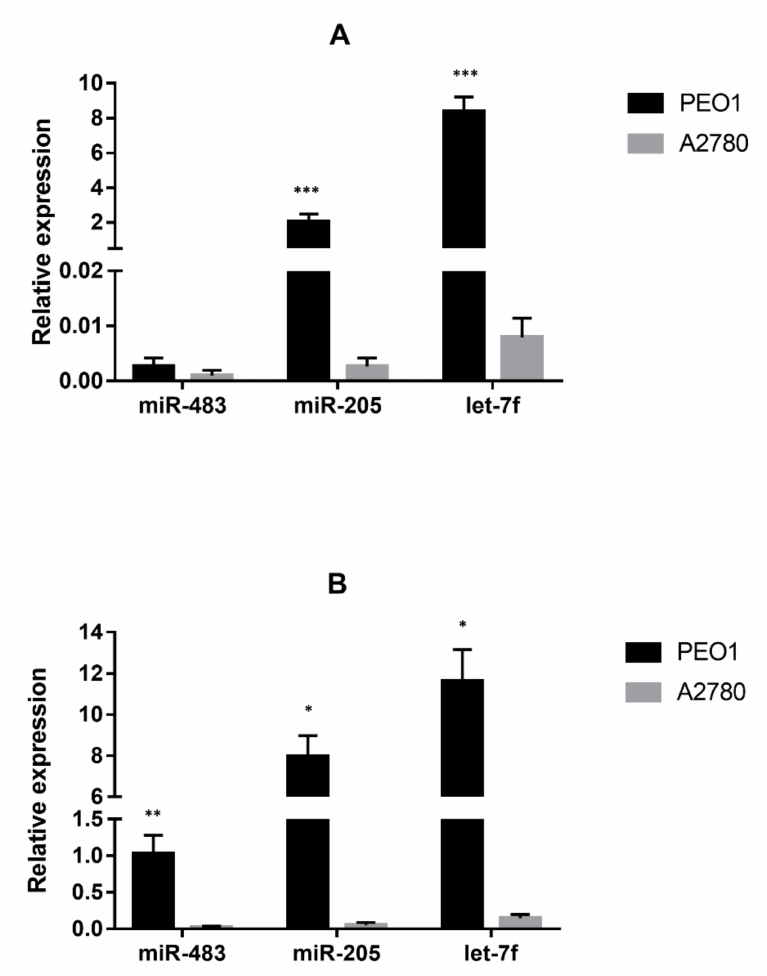
Figure 1. Basal expression levels of miR-483-5p, miR-205-5p, and let-7f-5p in the PEO1 and A2780 cell lines. ( A ) Intracellular miRNA expression: miRNA expression was detected in the cell lysates. ( B ) Cell-free miRNA expression: miRNAs were isolated from the supernatant of the cultures. Data are presented as mean ± S.D. Significance was determined by Student’s t -test between the ∆ CT values of the PEO1 and A2780 cell lines: * p < 0.05; ** p < 0.01; *** p <